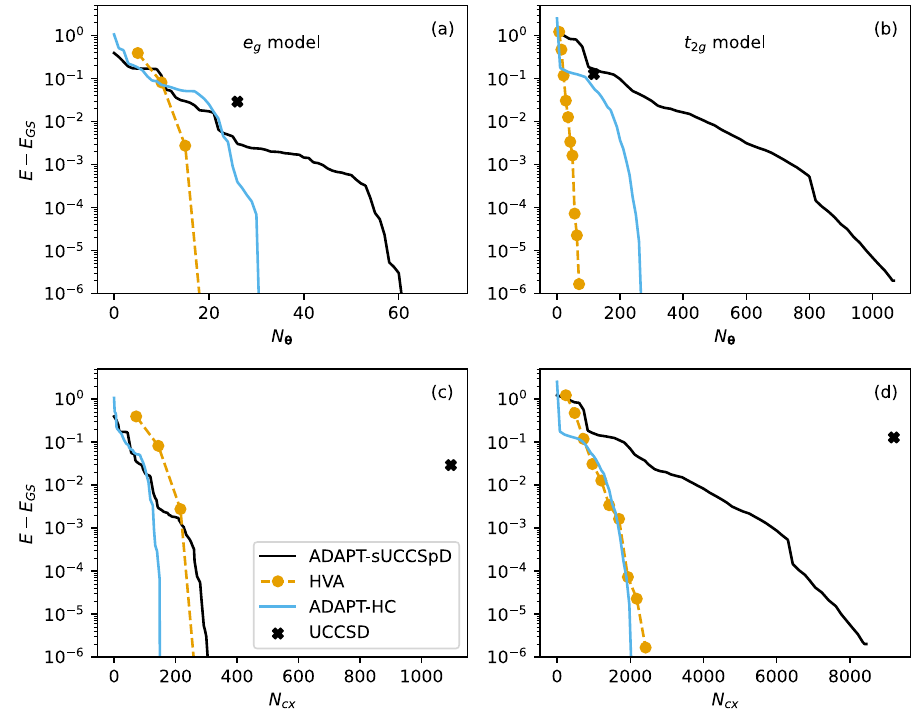
Fig. 3 Energy convergence of variational quantum eigensolver (VQE) calculations with four types of ansätze. Panels a , b show the energy difference between the variational and the exact ground state energy E GS as a function of a number of variational parameters N θ . Panels c , d show the energy difference versus the number of CNOT gates N cx . Panels a , c are for the degenerate ð N S ¼ 2 ; N B ¼ 2 Þ e g impurity model and panels b , d correspond to the (3, 3) t 2 g impurity model. VQE calculations are reported with fi xed Hamiltonian variational ansatz (HVA, orange dashed line) and unitary coupled cluster ansatz with single and double excitations (UCCSD, black cross) as well as with adaptive ansätze constructed from a simpli fi ed unitary coupled cluster pool with single and paired double excitation operators (sUCCSpD, black line) and a Hamiltonian commutator pool (HC, sky blue line). Here N cx is estimated according to each multi-qubit rotation gate with a Pauli string generator P of length l contributing 2( l − 1) CNOT gates, which assumes a full qubit connection. The Hamiltonian parameters are ϵ = − 9.8( − 12.7), λ = 0.3(0.1), D ¼ (cid:2) 0 : 3 ð(cid:2) 0 : 3 Þ with the same Hubbard U = 7 for the e g ( t 2 g ) model, corresponding to the correlated bad metallic regime. The energy unit is the half-band width D of the noninteracting DOS for the multi-band lattice model (see Fig.